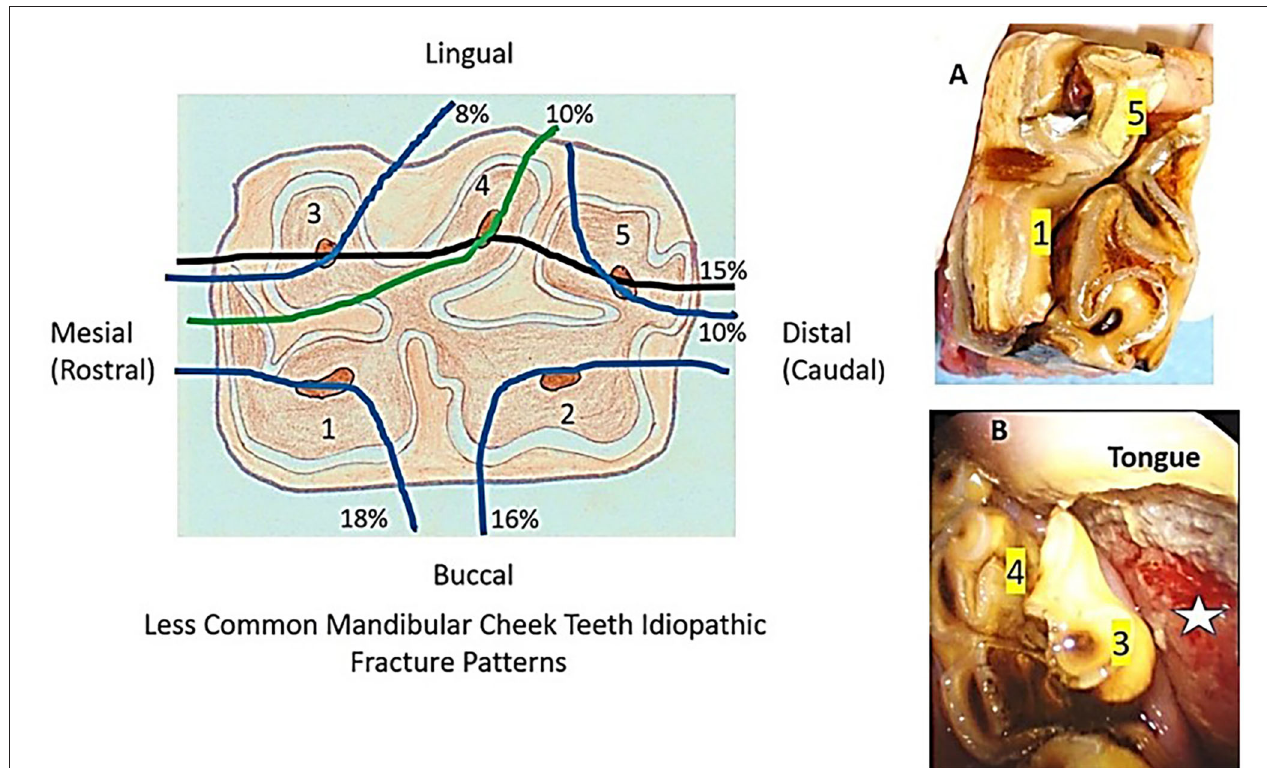
FIGURE 5 | The diagram on the left shows the six most common idiopathic mandibular cheek teeth fracture planes (five through single pulp horns) other than slab fractures (i.e., “atypical fractures”) and the proportions of each fracture plane in this category. The top right image (A) shows an extracted tooth with a fracture extending through the first and fifth pulp horns. The bottom right image (B) is an intra-oral view of an oblique fracture through the fourth pulp horn (similar to that shown in the diagram on the left). The smaller displaced fragment (containing the third pulp horn) remains attached by its periodontal and gingival attachments and has caused severe tongue ulceration (star).